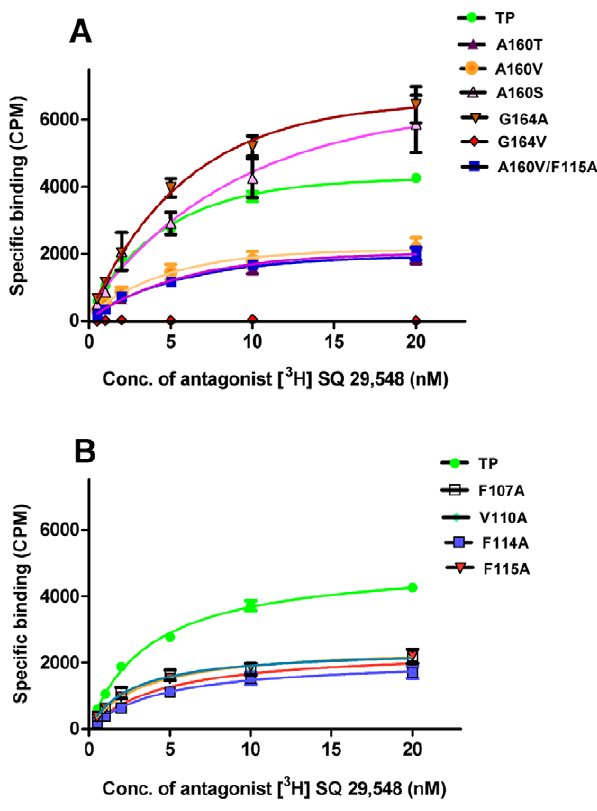
Figure 2. Saturation binding assays of wild type TP and the mutant receptors using the TP antagonist [ 3 H] SQ 29,548. Saturation assays with membrane bound TP and the mutant receptors, TM4 mutants in panel A and TM3 mutants in panel B, were performed with different concentrations of [ 3 H] SQ 29,548. A one way ANOVA analysis without any post hoc test showed that except for G164V in TM4 there were no significant difference between TP and the mutants at significance level of p , 0.05. The data is from a minimum of three independent experiments, with each point in duplicate. doi:10.1371/journal.pone.0029996.g002 PLoS ONE |